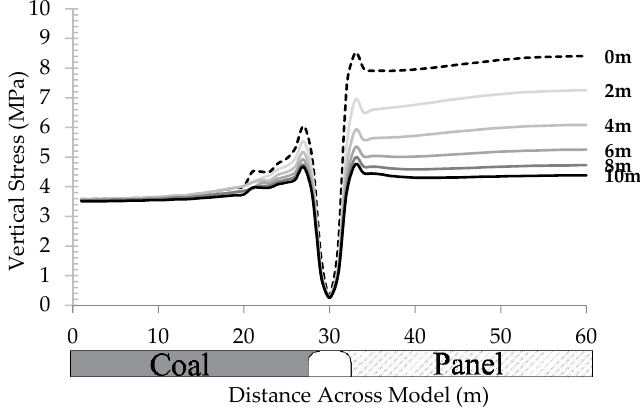
Figure 16. Vertical stress with different distance from the longwall face for 100 m of depth.